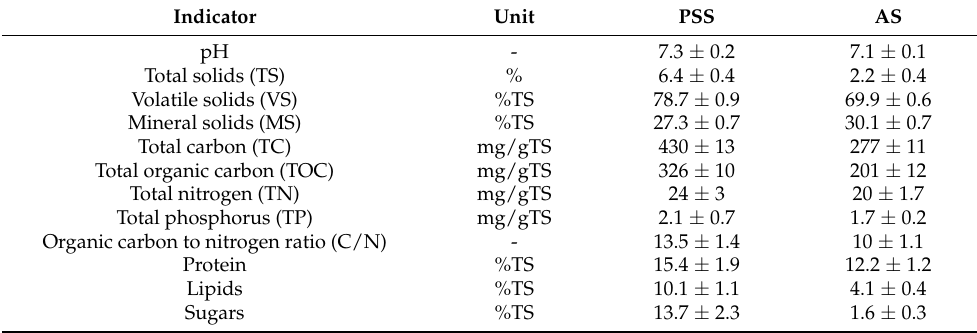
Table 2. Characteristics of the PSS and AS used in the study.